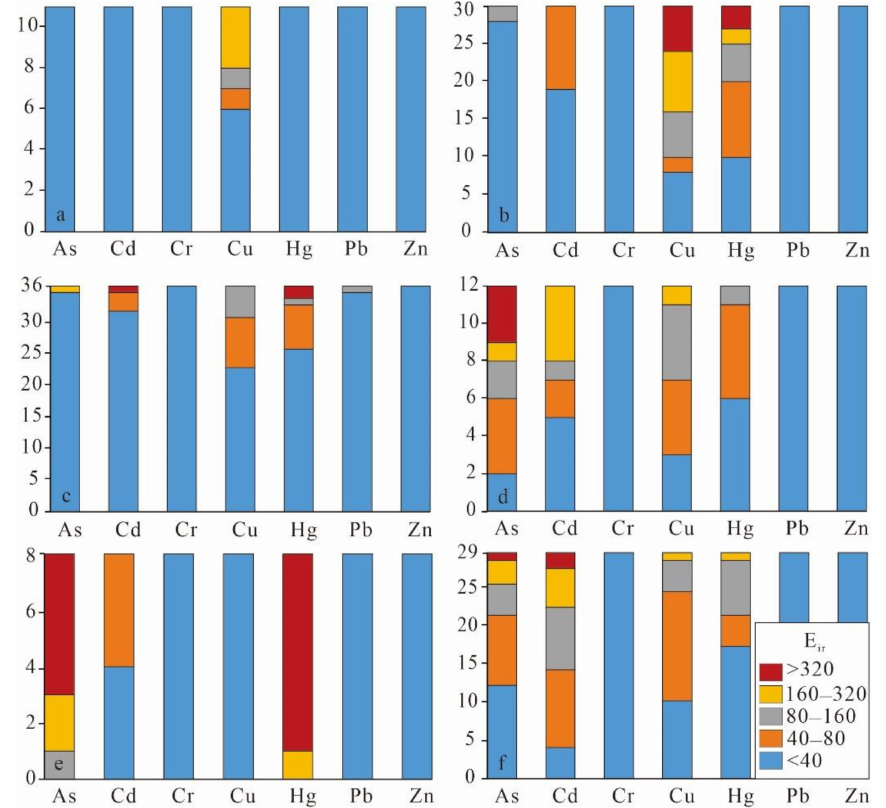
Figure 9. Number of E ir levels for sediments samples in different streams: ( a ) Fuxi tributary, ( b ) Dawu tributary, ( c ) Le’an River, ( d ) Fujiawu tributary, ( e ) Jinshan tributary, and ( f ) Dexing